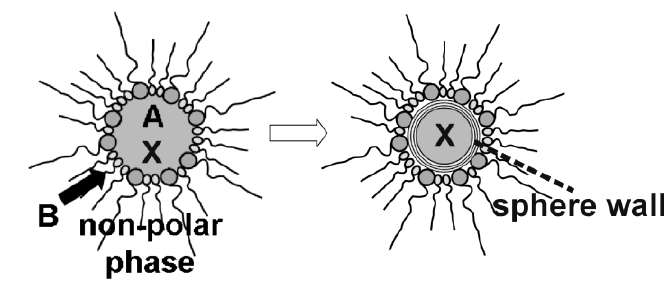
Figure 13. Scheme showing the encapsulation of compounds (X) prior to hollow sphere formation via reaction of the starting materials (A and B) at the liquid-to-liquid phase boundary of w/o